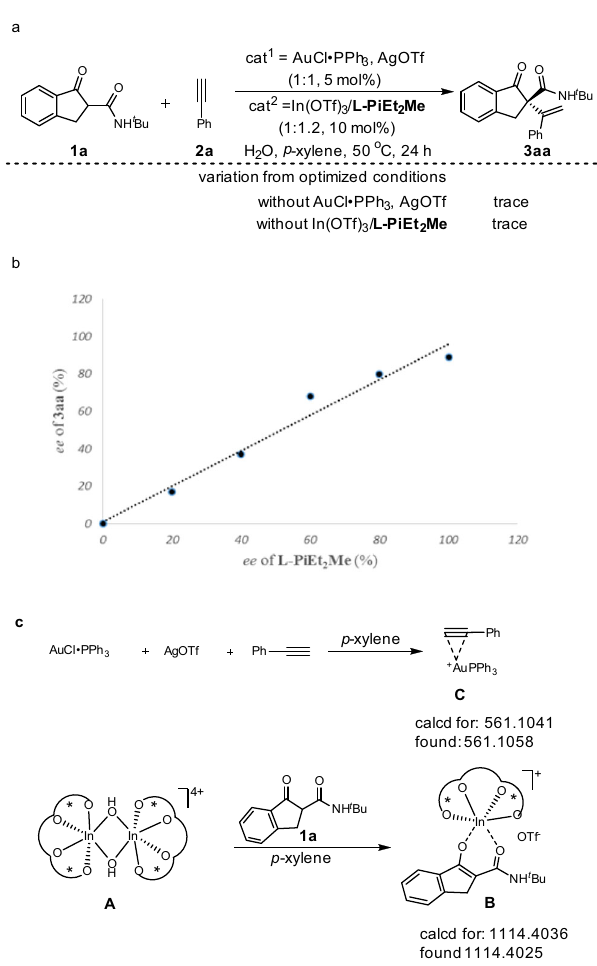
Fig. 6 Mechanism investigation. a Control experiments for reaction conditions. b The relationship between the ee value of L-PiEt 2 Me and 3aa . c The ESI-TOF analysis of intermediate B and C .